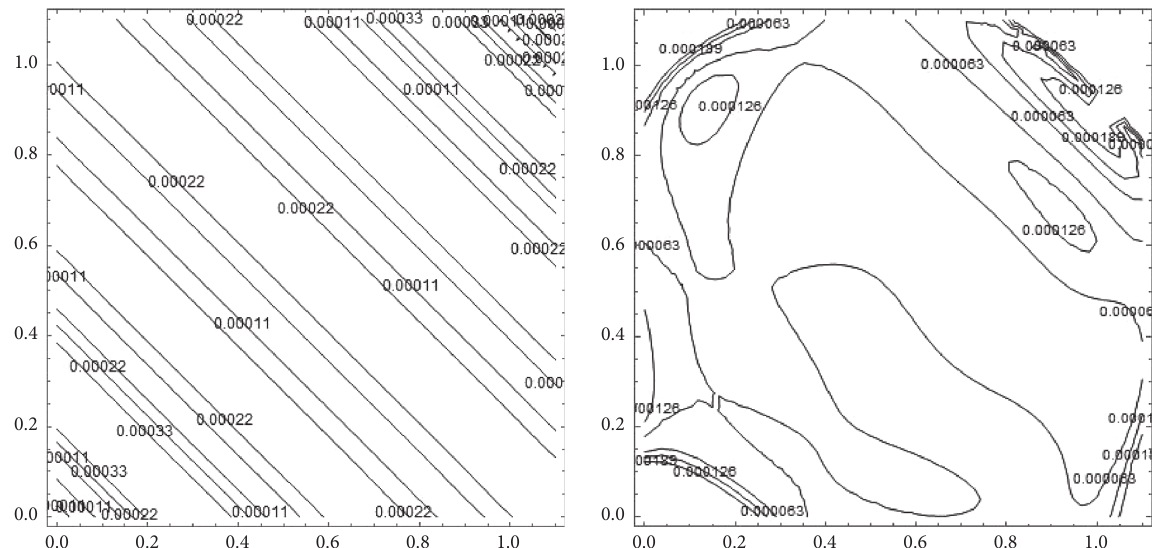
Figure 11: Contour plot errors in both mesh and meshless